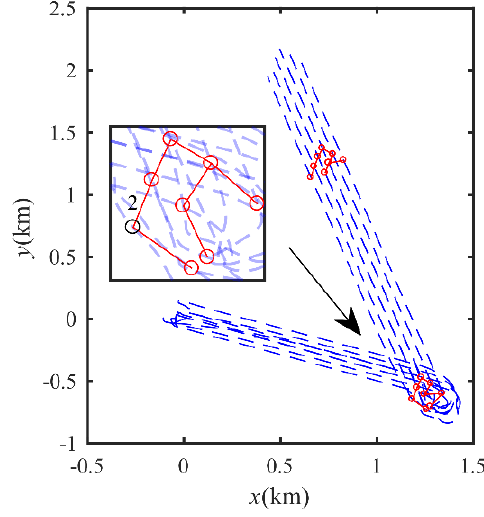
Figure 11. Track with communication breaks (test 2).